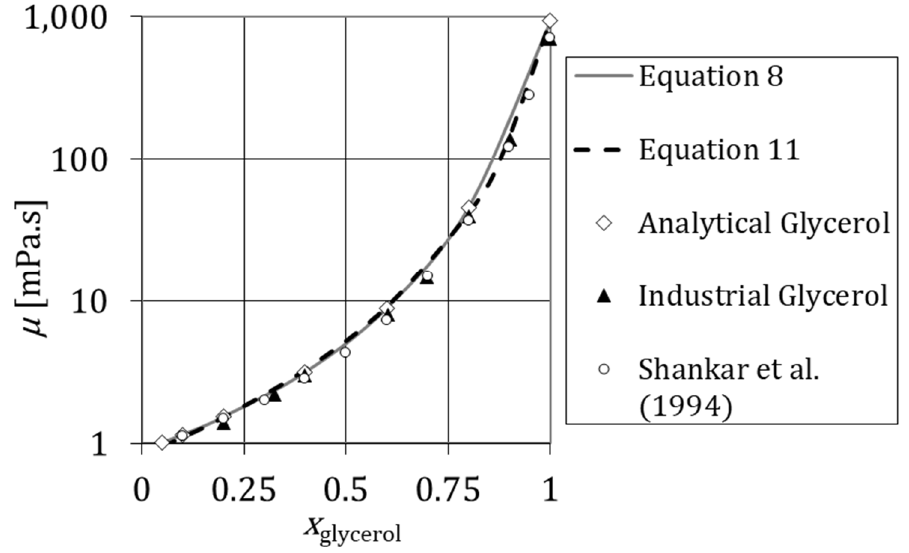
Figure 5. Variation of viscosity of aqueous solutions of glycerol with the mass fraction of glycerol at θ = 298.15 K measured experimentally (Analytical Glycerol and Industrial Glycerol) and the respective comparison with Equation (8), Equation (10) and the data in the literature [47] .